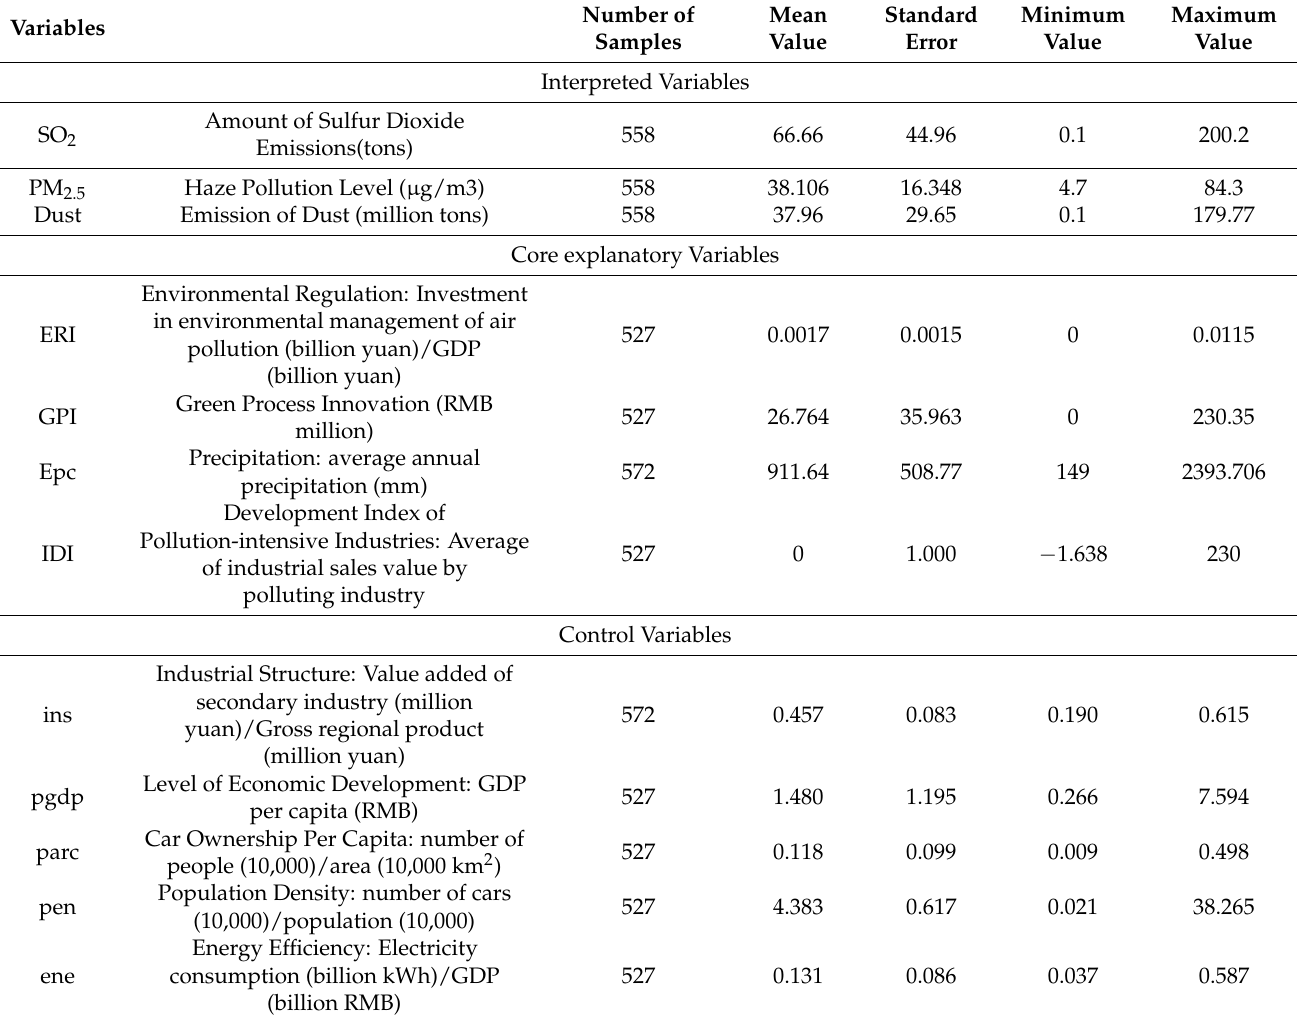
Table 1. Model variable selection and descriptive analysis.